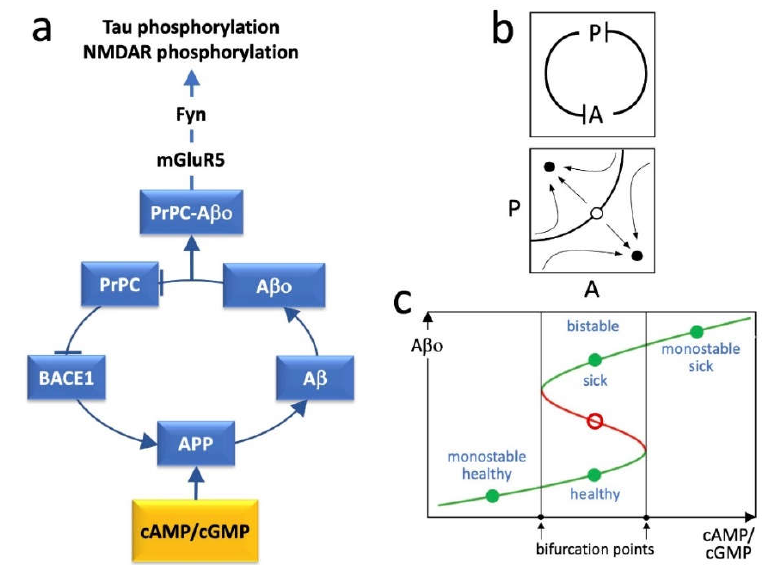
Figure 1. ( a ) Schematic graph of the proposed AD pathogenic loop showing the involved molecular agents. Cyclic nucleotides act as external elements providing an input to the loop in correspondence of its APP component. Arrow-ended lines = activation; bar-ended lines = inhibition; APP = amyloid precursor protein; A β = amyloid- β ; A β o = amyloid- β olygomers; BACE1 = β -secretase 1; Fyn = Fyn kinase; mGluR5 = metabotropic glutamate receptor 5; PrPC = cellular prion protein. ( b ) Top panel: simplified diagram of the loop system reported in ( a ), where A represents the complex of agents, from BACE1 to A β o, and P represents PrPC. Bottom panel: bidimensional phase portrait in the P/A plane showing hypothetical attraction basins of stable equilibrium points (filled circles) and an unstable equilibrium point (open circle). ( c ) Curve of the steady states (equilibrium points) of A β o, representing a loop variable, as a function of cAMP/cGMP stimulus. The latter acts as a bifurcation parameter able to shift the loop dynamics from monostability to bistability. In the bistable zone, the system admits two stable equilibrium points and an unstable one for each cAMP/cGMP input. Green curve branches and filled circles = stable equilibrium points; red curve branch and open circle = unstable equilibrium